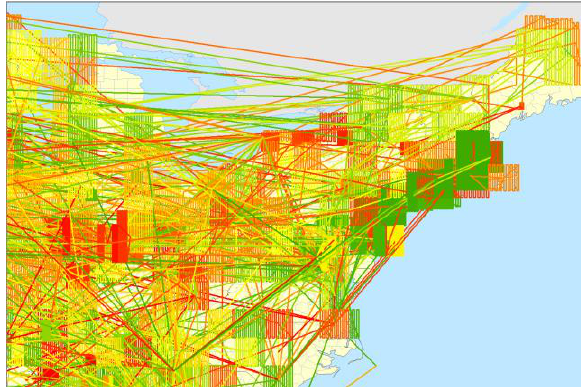
Figure 3: Simulated flight pattern over the N-E US for a 6-month period. Color indicates different flight dates.